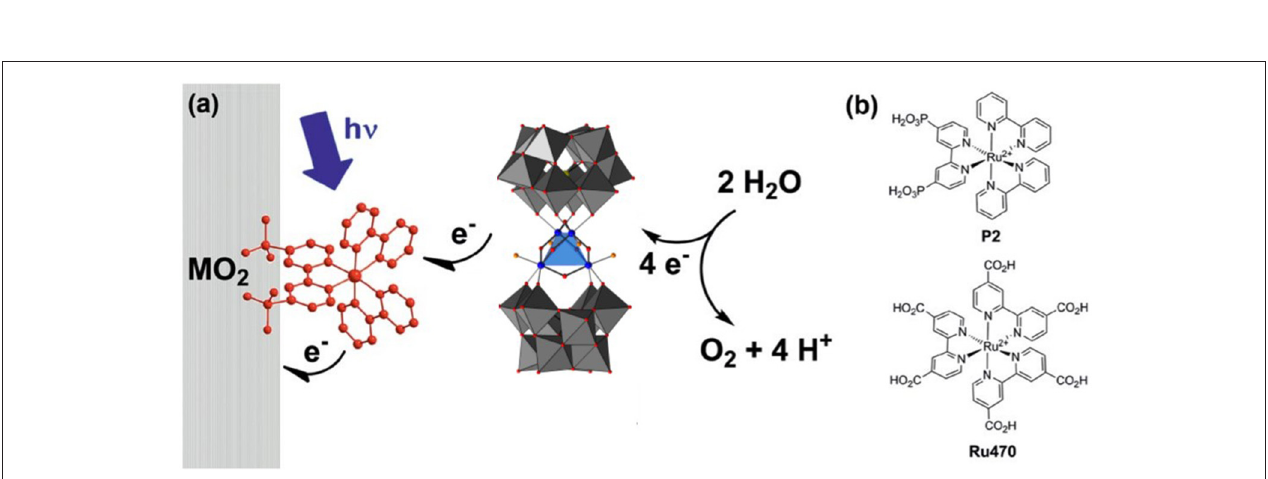
FIGURE 4 | (a) Principle of operation of a triadic water-oxidizing photoanode incorporating both Ru 4 Si 2 and a dye. (b) Structures of the dyes which have been used in triads with Ru 4 Si 2 (Xiang et al., 2013). Adapted with permission from J. Phys Chem. C., 2013, 117 (2), pp 918–926. Copyright 2013, American Chemical Society.